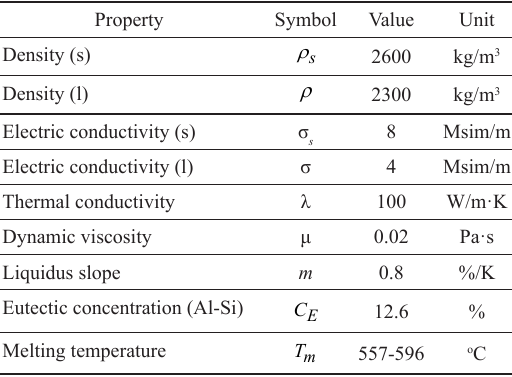
Figure 3. Schematic image of dendritic directional solidification and mushy zone. Electric current and magnetic field caused convection: u-crucible scale, v- dendrite